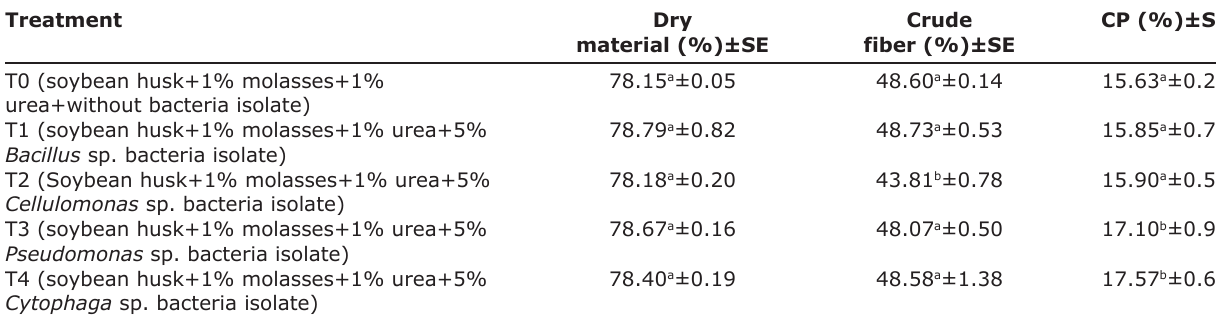
Table-2: The content of dry material (%), crude fiber (%), and CP (%) of fermented soybean husk using various cellulolytic bacteria isolates from S. litura . Treatment